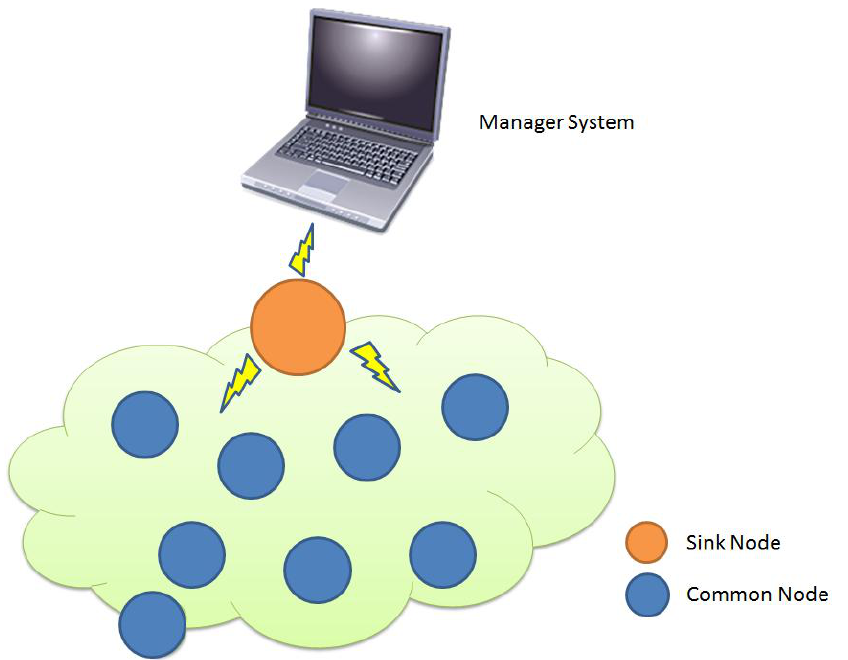
Figure 2. Sensor Network